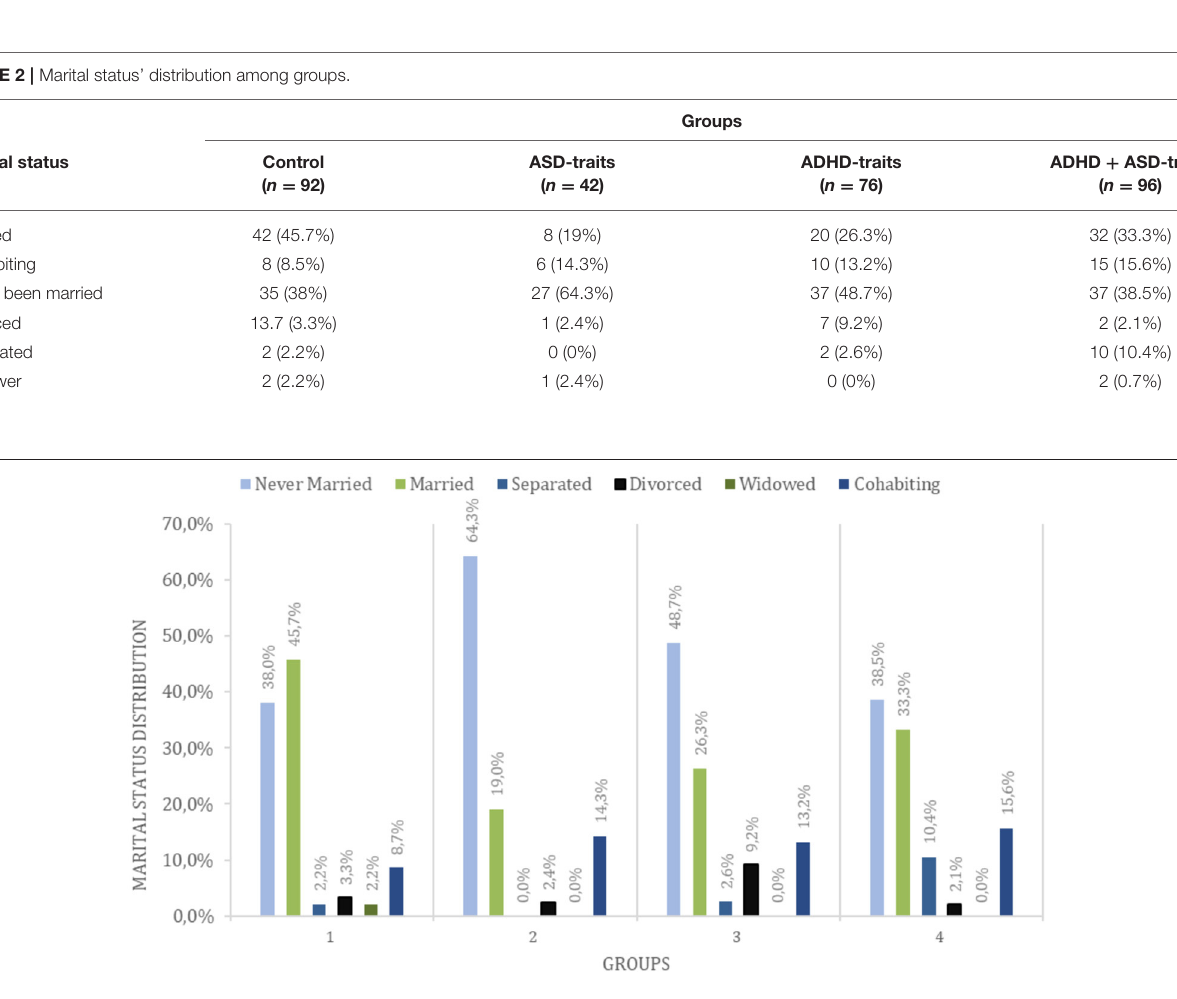
FIGURE 1 | Marital status distribution by group. 1 = Control group, 2 = ASD-traits group, 3 = A DHD-traits group, 4 = ADHD + ASD-traits group.